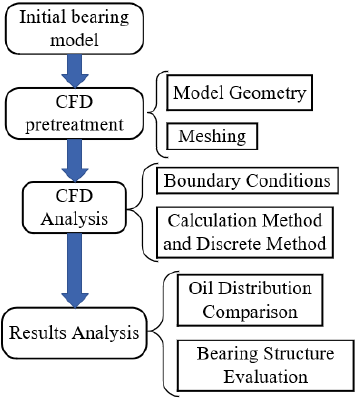
Figure 3. Bearing CFD analysis flow chart.